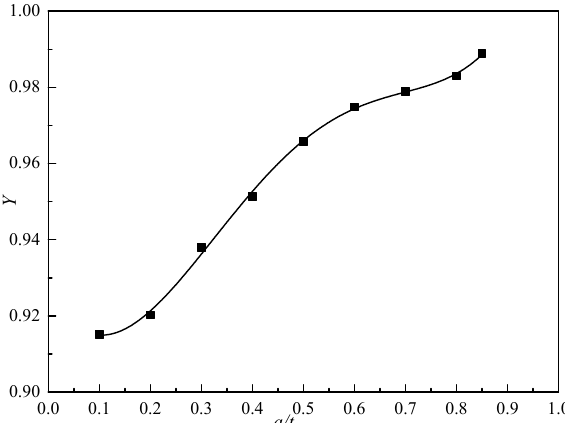
Figure 8. Curve of geometric correction coefficient Y with respect to a / t.